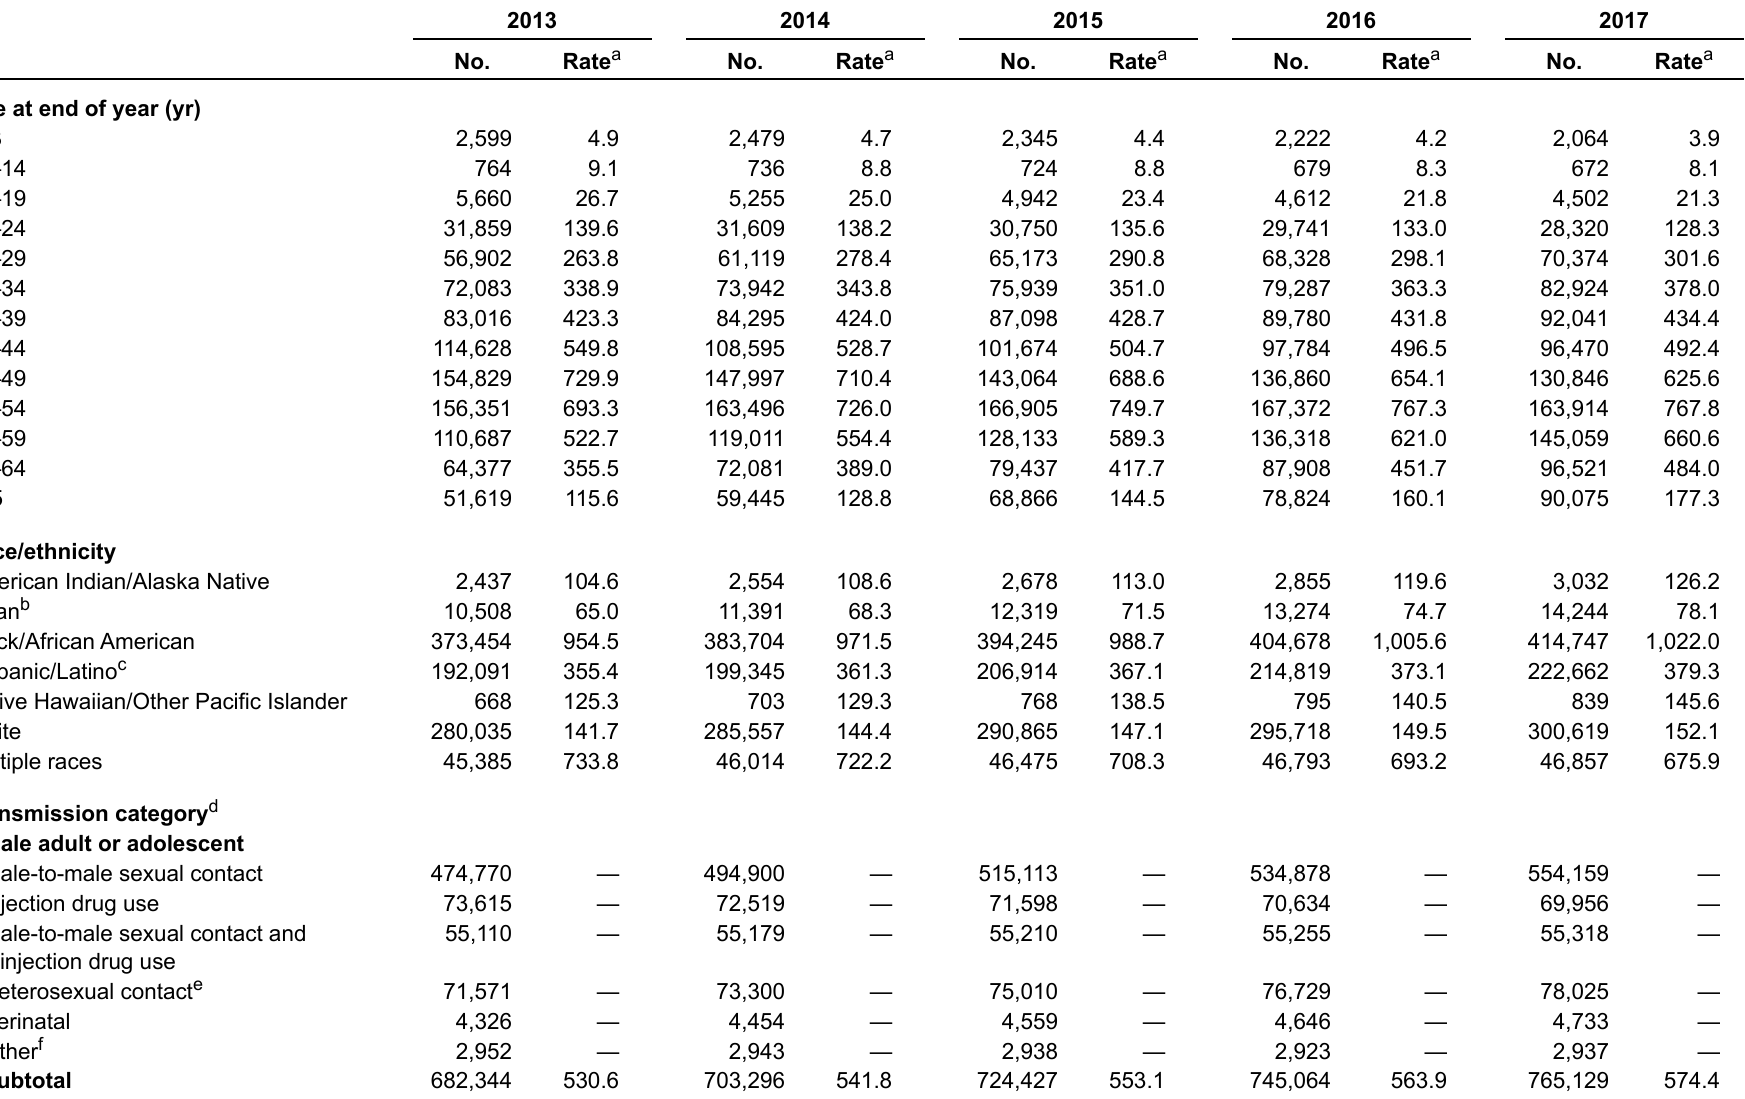
Table 22a. Persons living with diagnosed HIV infection, by year and selected characteristics, 2013–2017—United